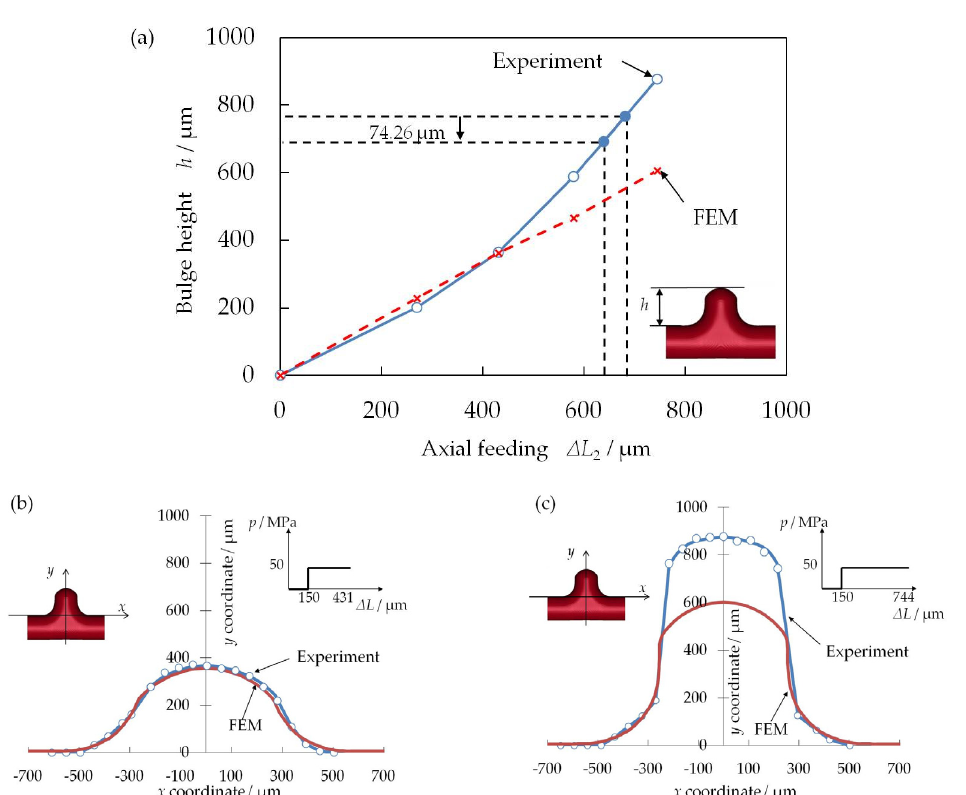
Figure 10. Bulging behavior and bulge shape in experiment and simulation ( μ s = 0.01 and μ d = 0.005) (C1220, fluorocarbon): ( a ) bulging behavior; ( b ) bulge shape at Δ L 2 = 431 μ m; ( c ) bulge shape at Δ L 2 = 744 μ m.